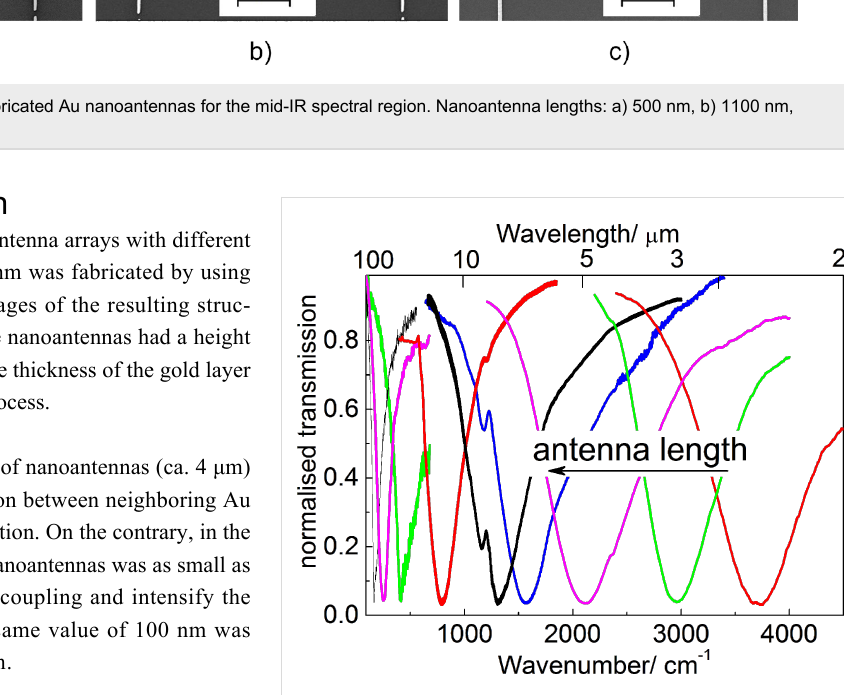
Figure 2: Typical IR transmission spectra of linear antennas with dif- ferent lengths.